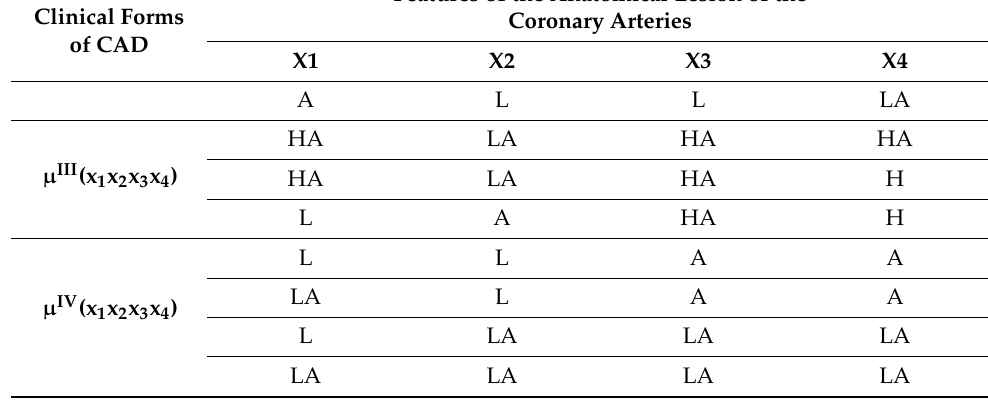
Table 4. Cont. Clinical Forms of